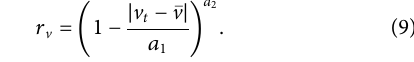
v t by comparing it with the average velocity (cid:2) v of the center of mass of the snake robot. The velocity reward is given by